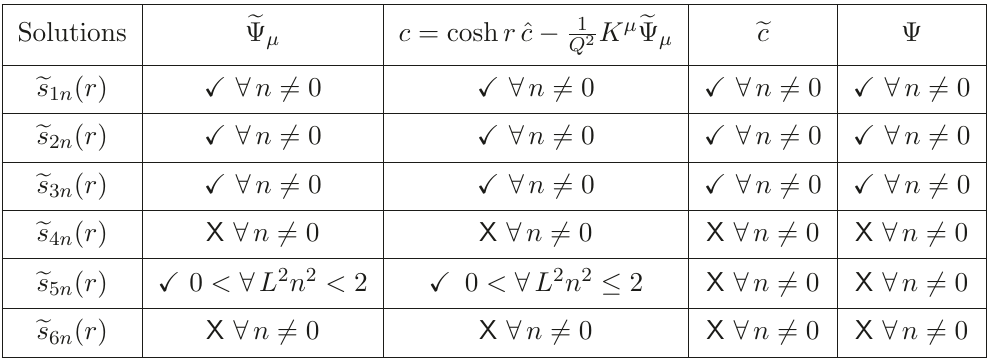
Table 1 . Summary of acceptable and non acceptable solutions for fermionic fields. field and, therefore, for the modes lying in the interval, 0 < L 2 n 2 < 3 one loop determinant will not be just a boundary term but will also include bulk